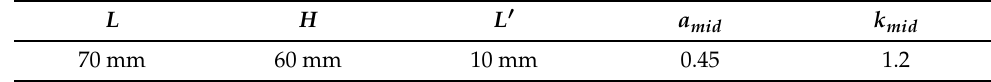
Table 2. The parameters for adhesion foot